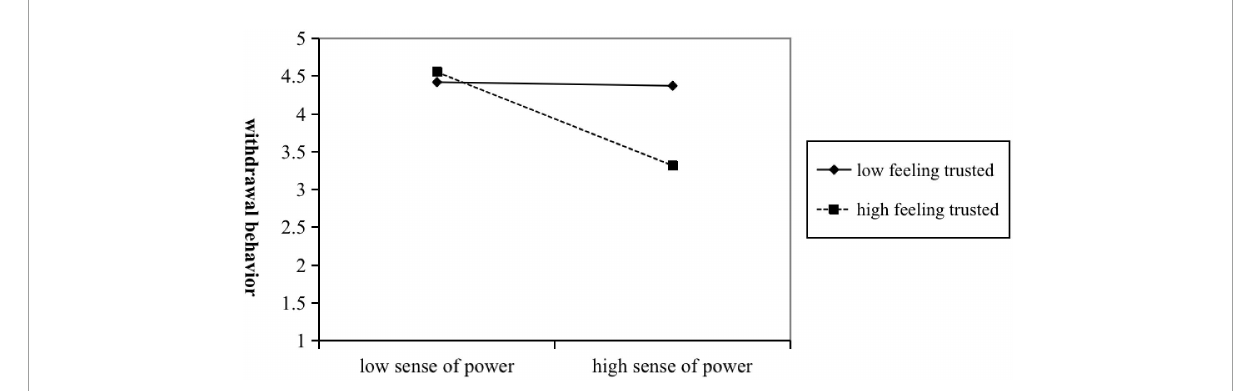
FIGURE3 Two-way interaction effect between sense of power and feeling trusted on withdrawal behaviors.